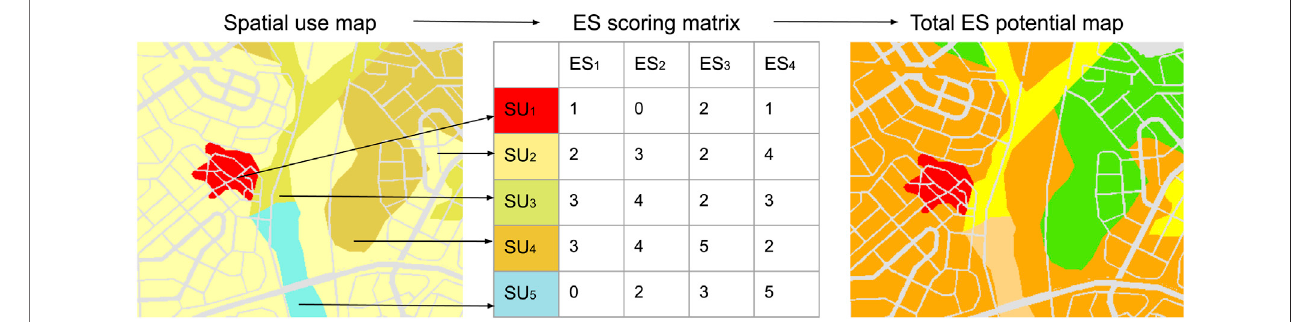
FIGURE 2 | Matrix model concept. (Adopted by Burkhard et al. (2009) and Jacobs et al. (2015)).